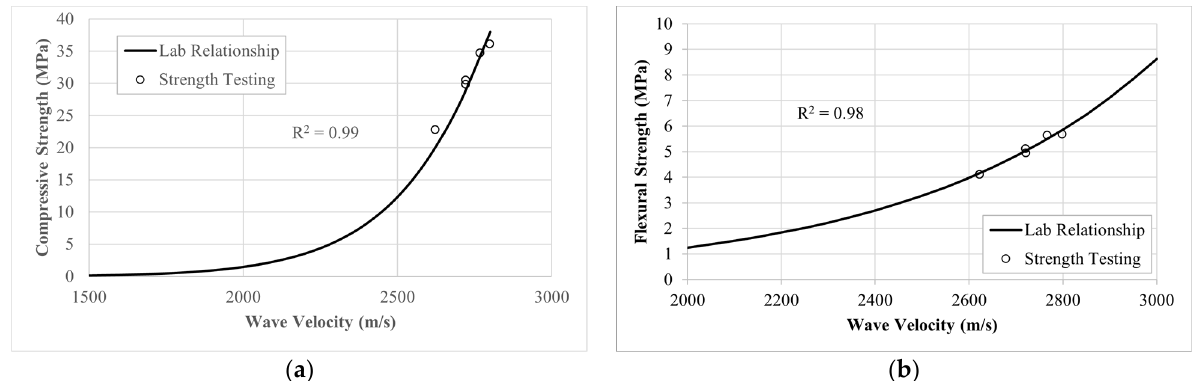
Figure 1. Test section maturity–strength relationships for ( a ) compressive strength and ( b ) flexural strength.